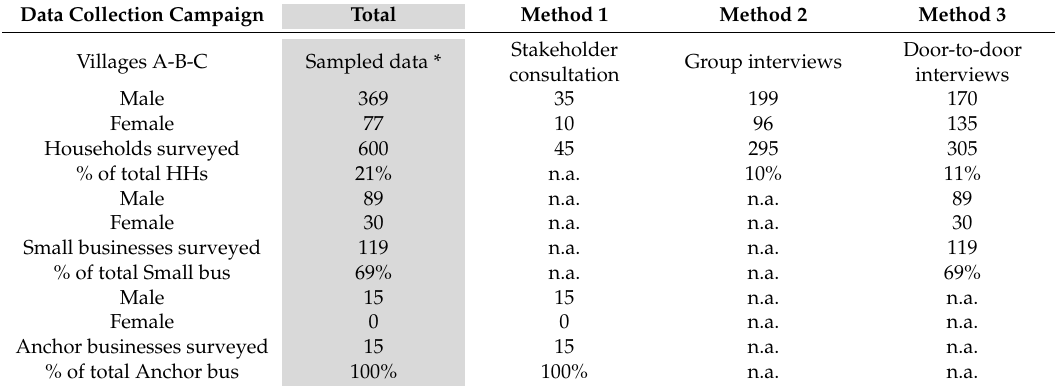
Table 2. Main survey figures considering gender balance and the sampling